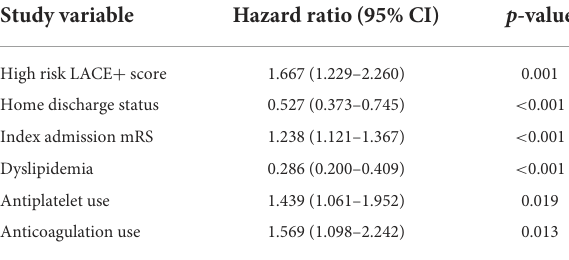
TABLE 2 Variables associated with 30-day unplanned readmission on multivariable